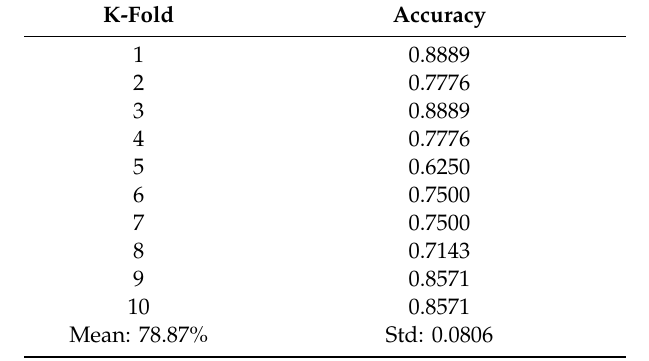
Table 8. Accuracies achieved by performing 5-Fold Cross-Validation on the SVM-RBF model.